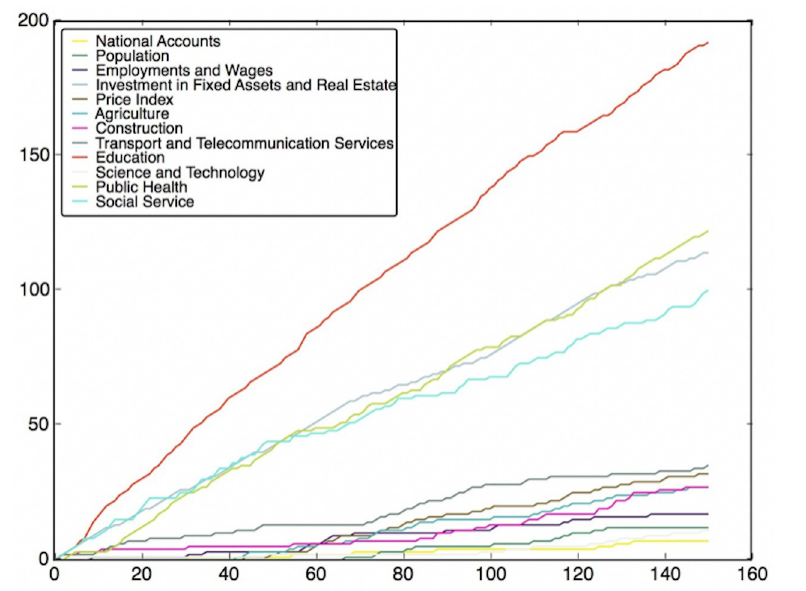
Fig 16. NNR with 5 features and clustering method.